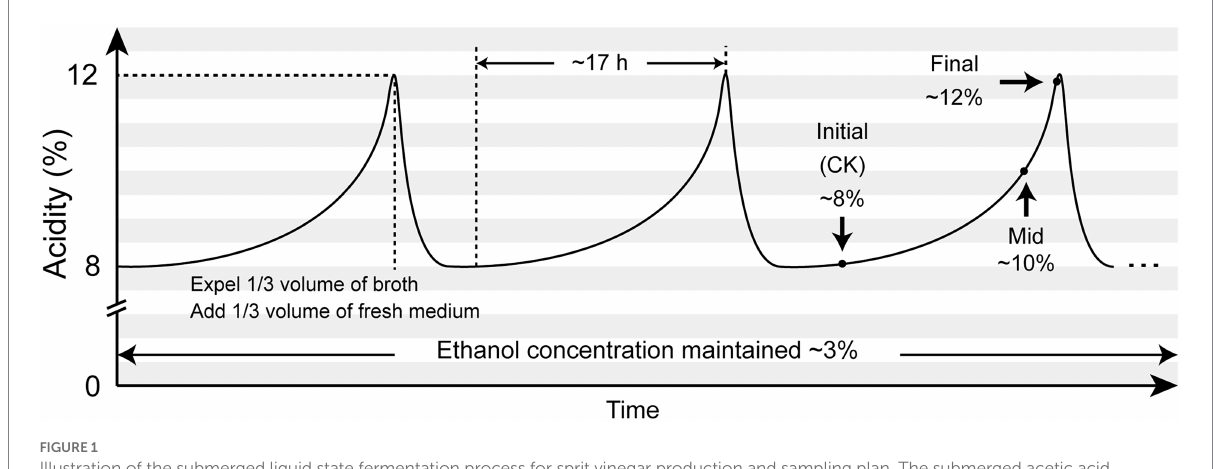
FIGURE 1 Illustration of the submerged liquid state fermentation process for sprit vinegar production and sampling plan. The submerged acetic acid fermentation was carried out uninterruptedly and periodically in a Chinese vinegar factory. Each fermentation period lasted for around 17 h, with the maximum acidity reaching around 12%. The concentration of ethanol was kept around 3% at all times. A fermentation period was terminated by discharging one-third volume of the fermentation broth, while a new period was initiated by adding another equal volume of the fresh medium. In this way, the acidity within the fermentor fluctuated between ~8% and ~12%. Samples for this transcriptomic study were collected at the initial, mid, and final stages within the same fermentation